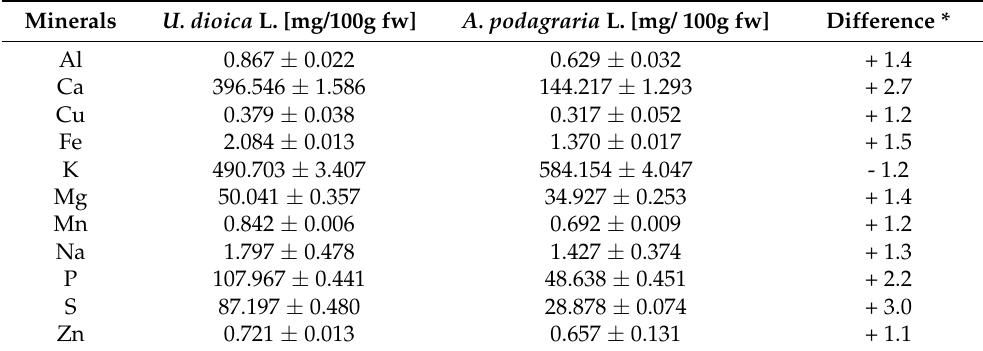
* Difference = U. dioica L. mineral concentration/ A. podagraria L. mineral concentration.